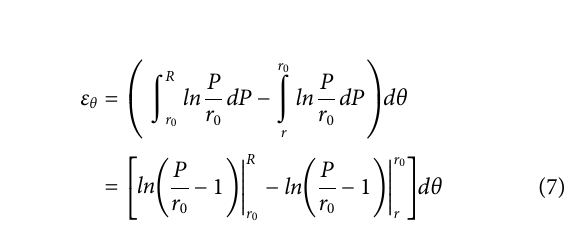
FIGURE 7 | Distributions of strain and grain sizes of the samples at different